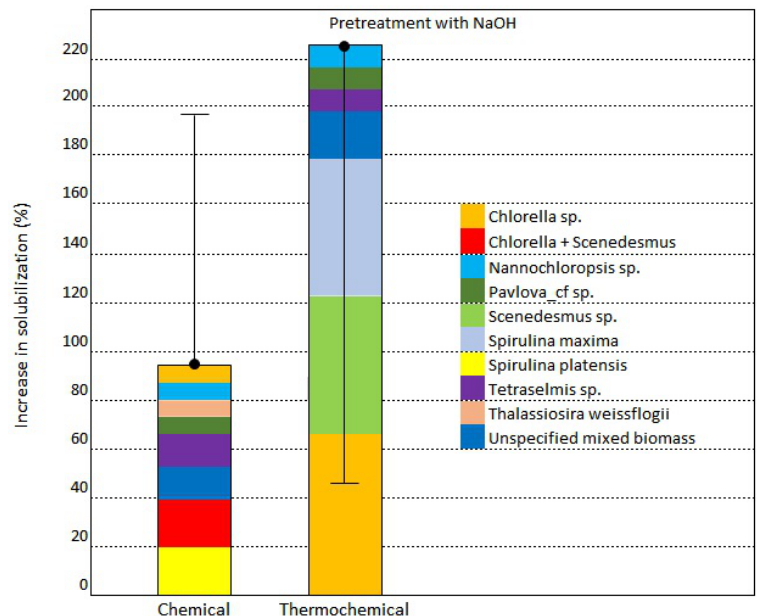
Figure 2. Mean and standard deviation for solubilization increase in different microalgae species after chemical and thermochemical pretreatment with NaOH. The colors in the two columns represent the contribution share of the different microalgae species in calculating the mean and standard deviation. Data from references [7,61,102,105,112,114].